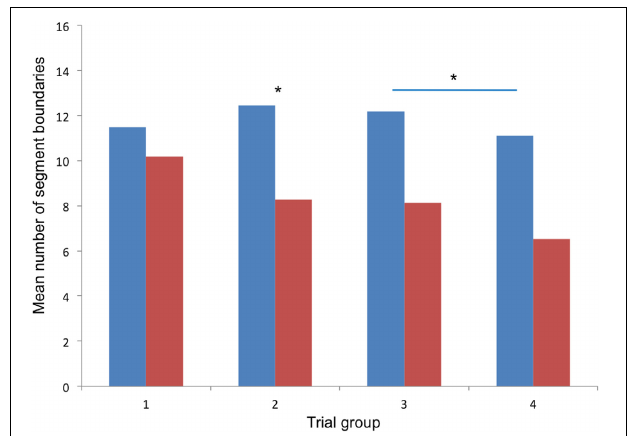
FIGURE 2 | Results of Experiment 2. Mean numbers of segment boundaries defined for the four groups of trials (1, early trials; 2, middle trials; 3, late trials; 4, music trials); blue columns: before learning, red columns: after learning; asterisks mark significant differences: ∗ p < 0 . 05.